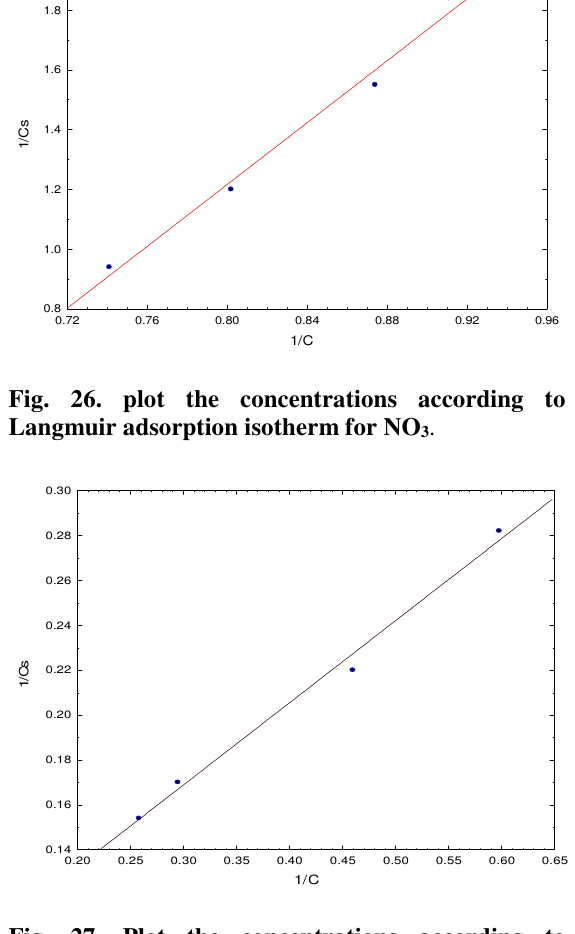
Fig. 27. Plot the concentrations according to Langmuir adsorption isotherm for PO 4 .